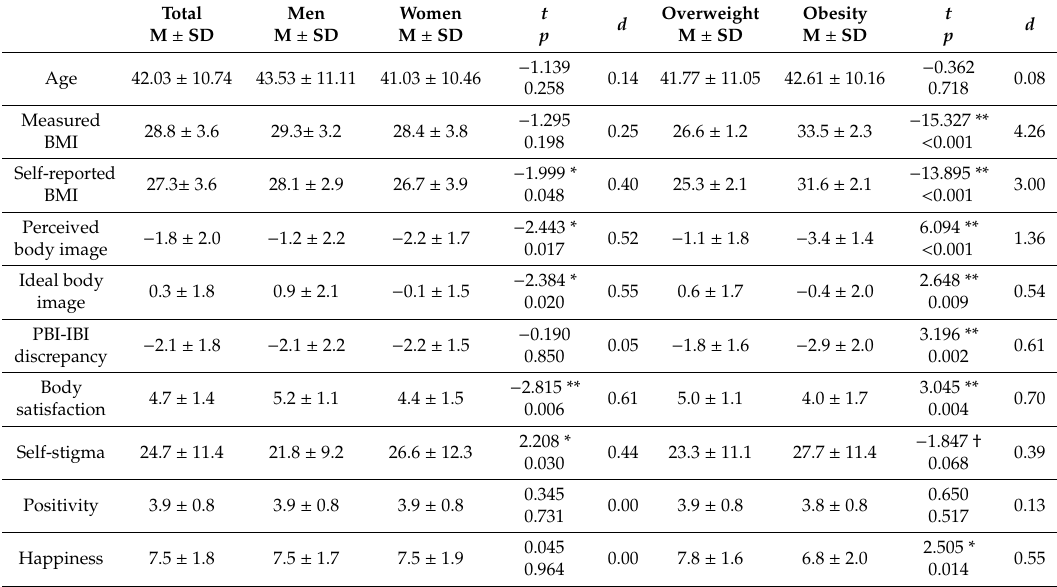
Table 1. Comparisons by sex / gender and body mass index (BMI)